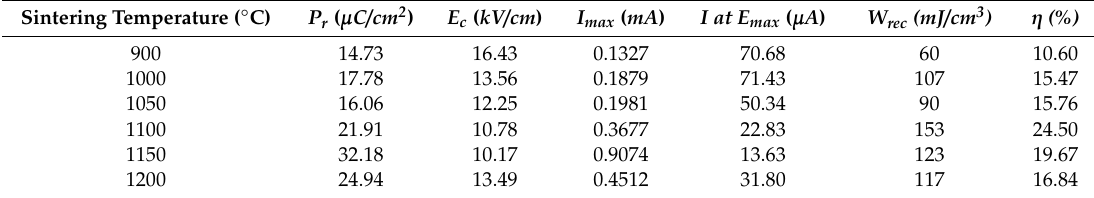
Table 3. Ferroelectric and energy storage properties of microwave-sintered PLZT 8 / 60 / 40 ceramics measured at 40 kV / cm.